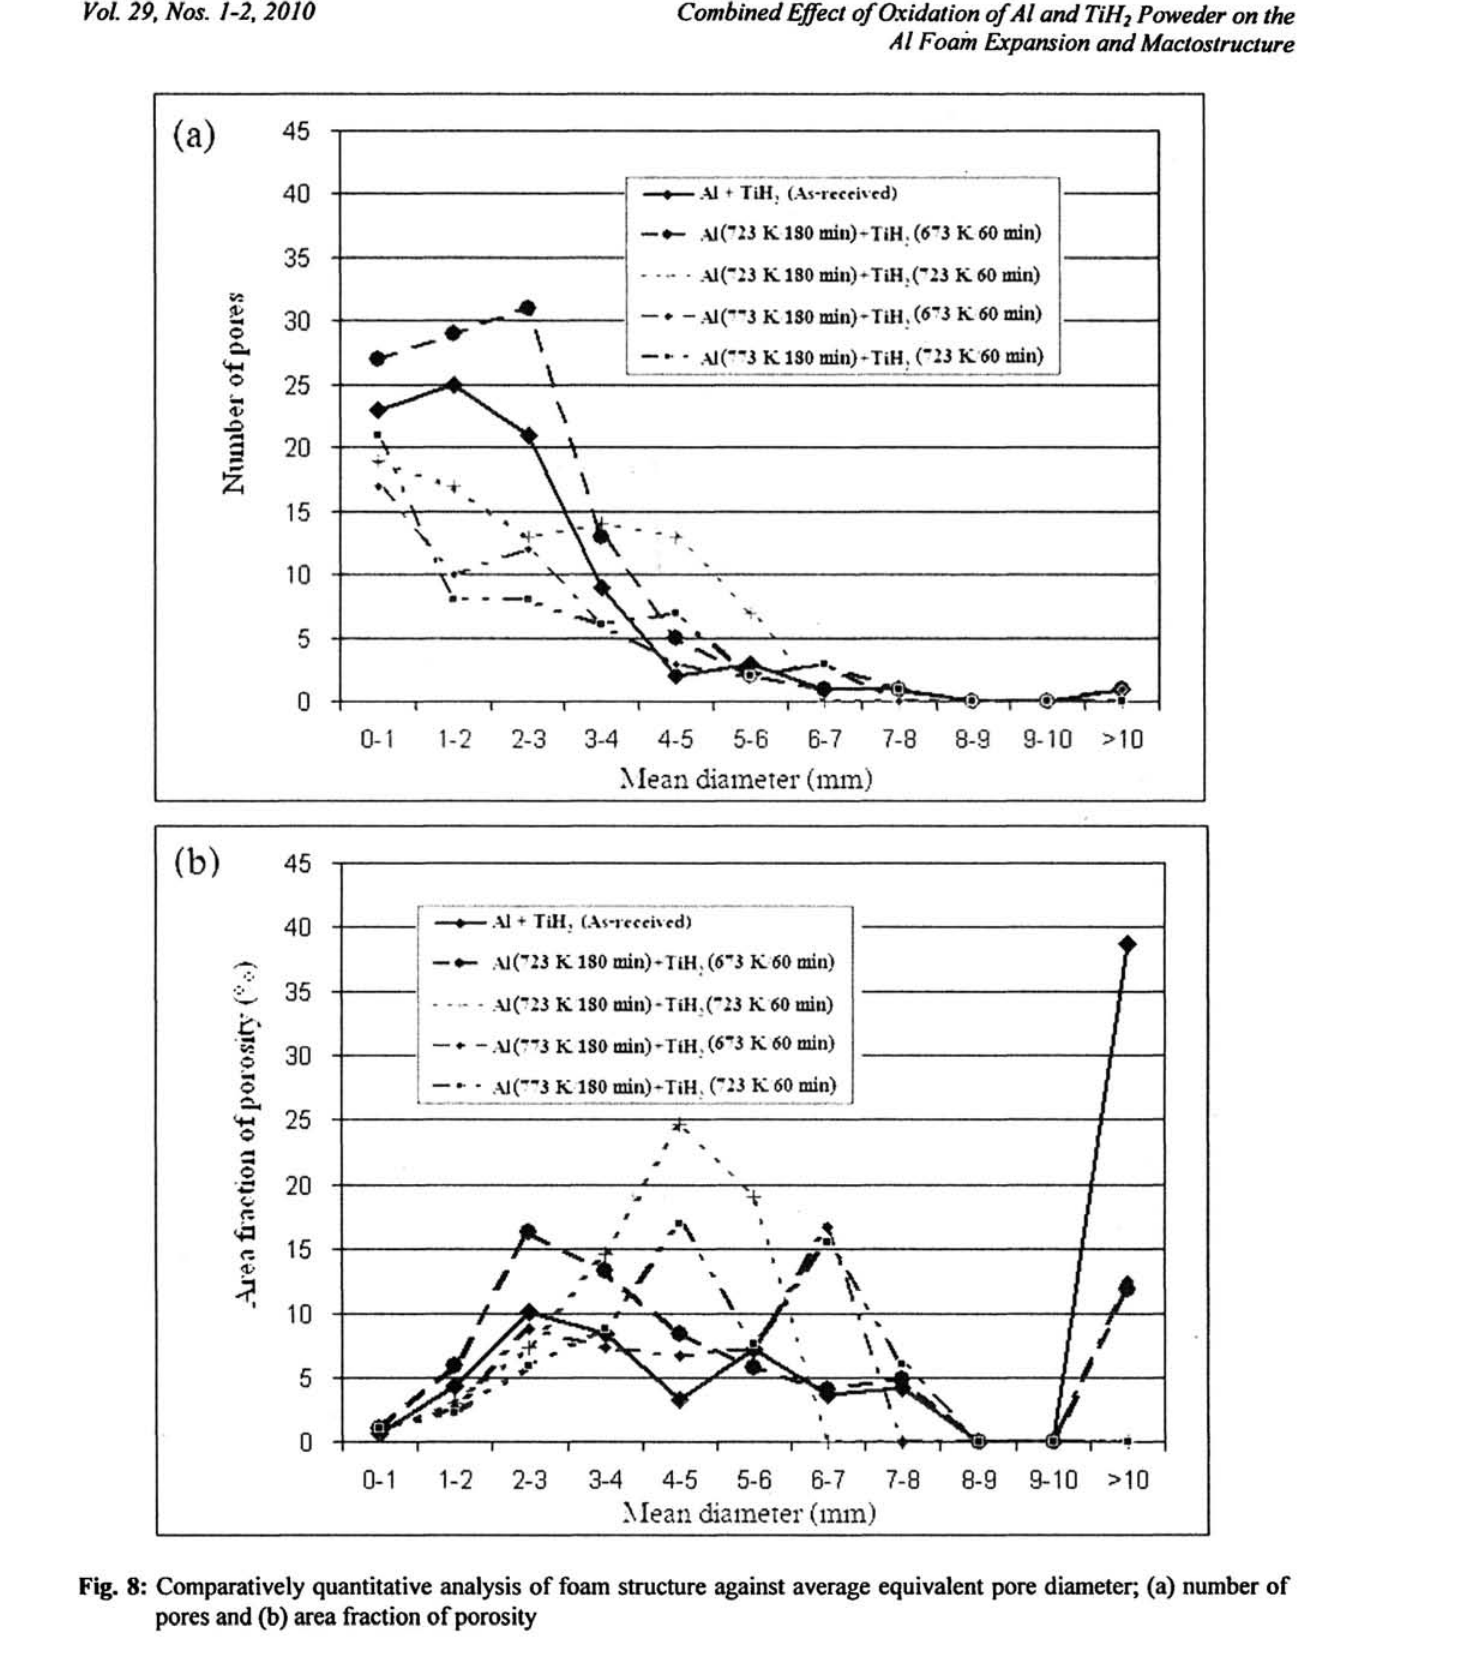
Fig. 8: Comparatively quantitative analysis of foam structure against average equivalent pore diameter, (a) number of pores and (b) area fraction of porosity